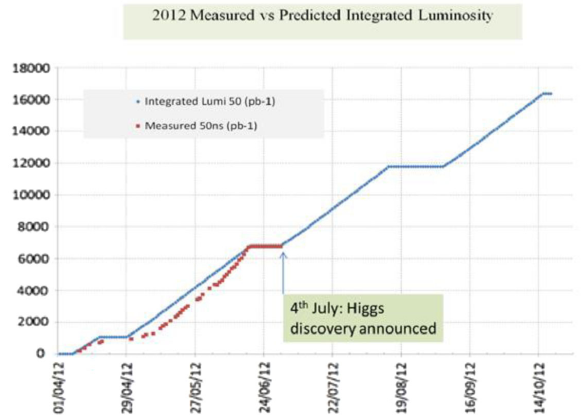
FIG. 29. Plot of predicted integrated luminosity in blue and measured in